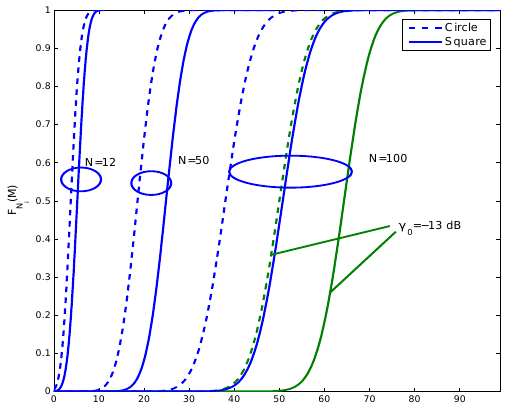
Fig. 4. CDF of the node neighborhood for different shapes of operating areas and network cardinalities. The SNR of the control channel =20 dB. All curves except of indicated ones correspond to the threshold value γ0 = −10 dB.